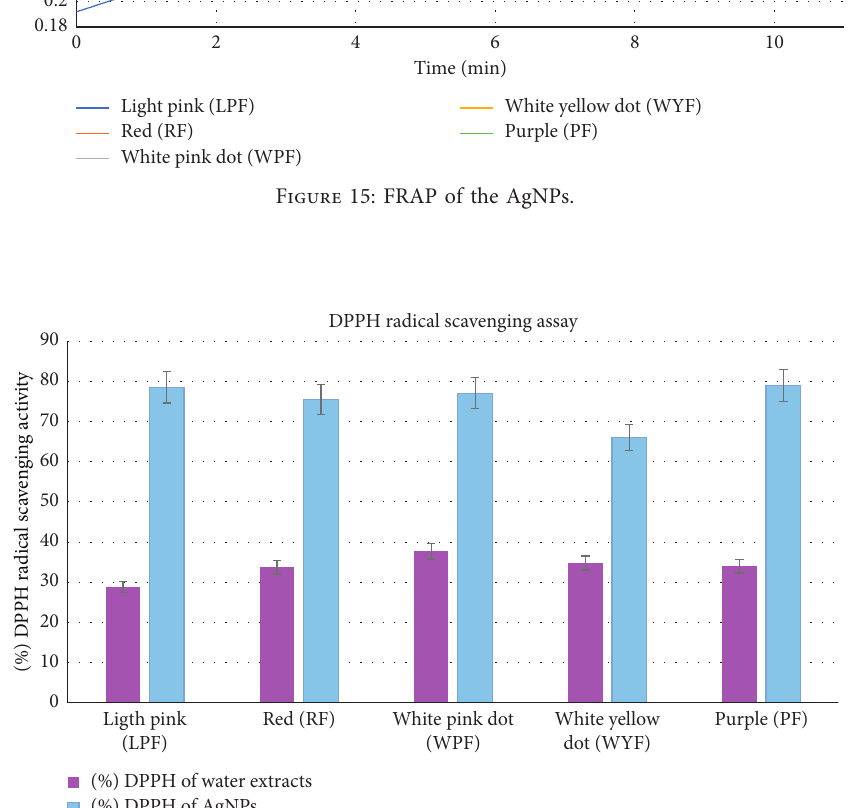
Figure 16: % DPPH scavenging activity of water extracts and AgNPs.